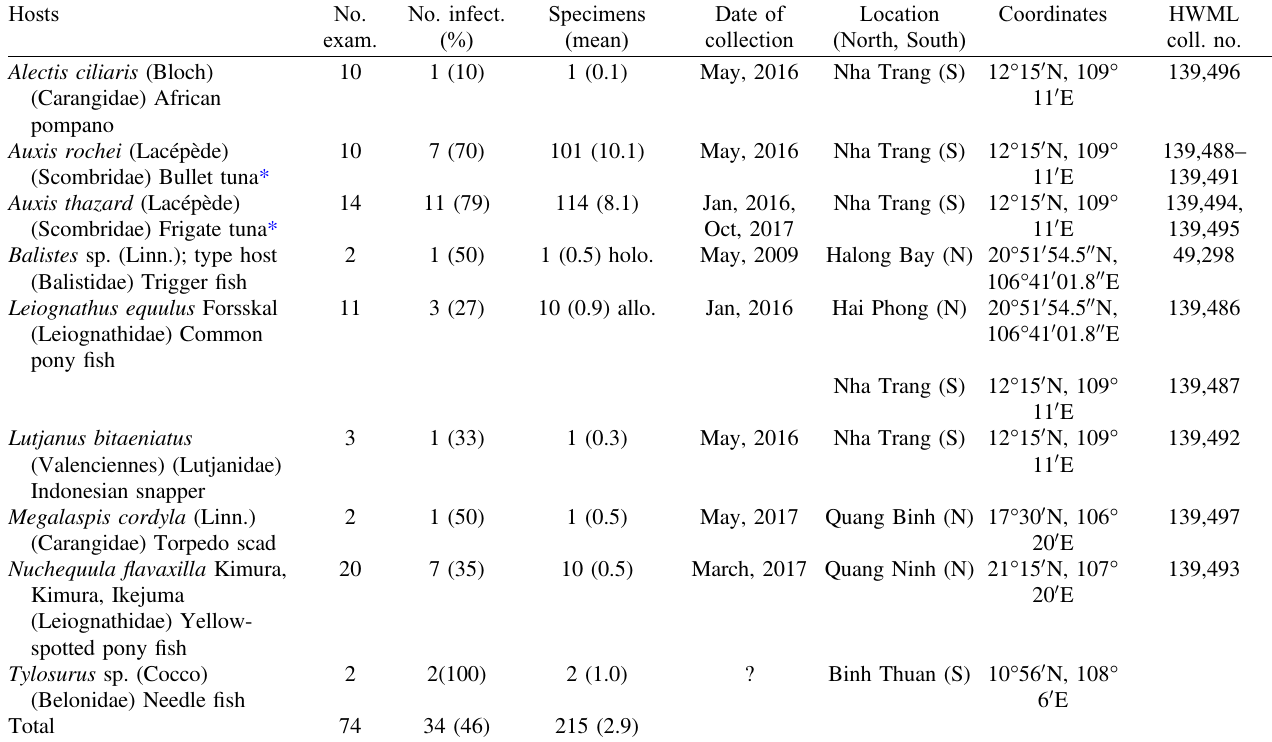
Table 1. Host and geographic distribution of Rhadinorhynchus laterospinosus in the Paci fi c Ocean off Vietnam. Hosts No. No. exam.